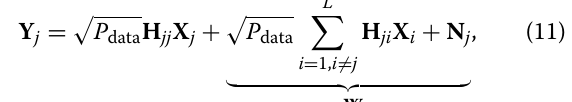
Algorithm 1, steps 2–9 gradually decrease the value of σ and maximize the objective function for each value of σ .